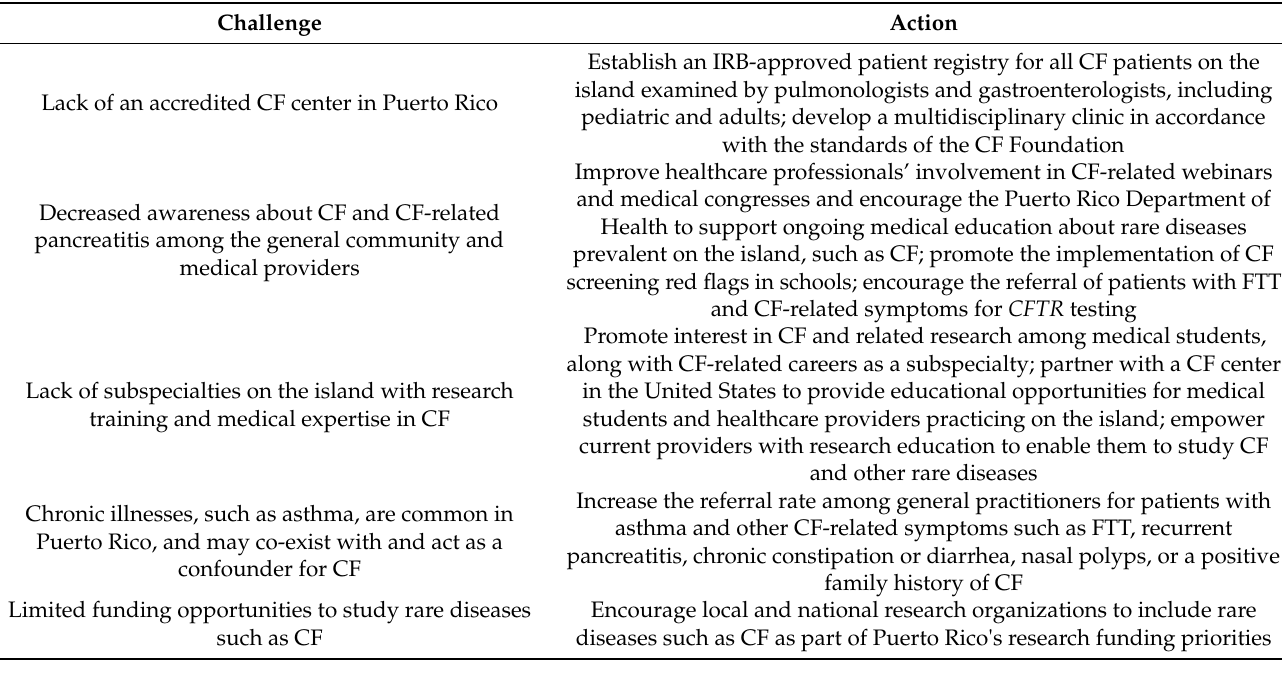
Table 5. Challenges to studying and treating CF and CF-related pancreatitis in Puerto